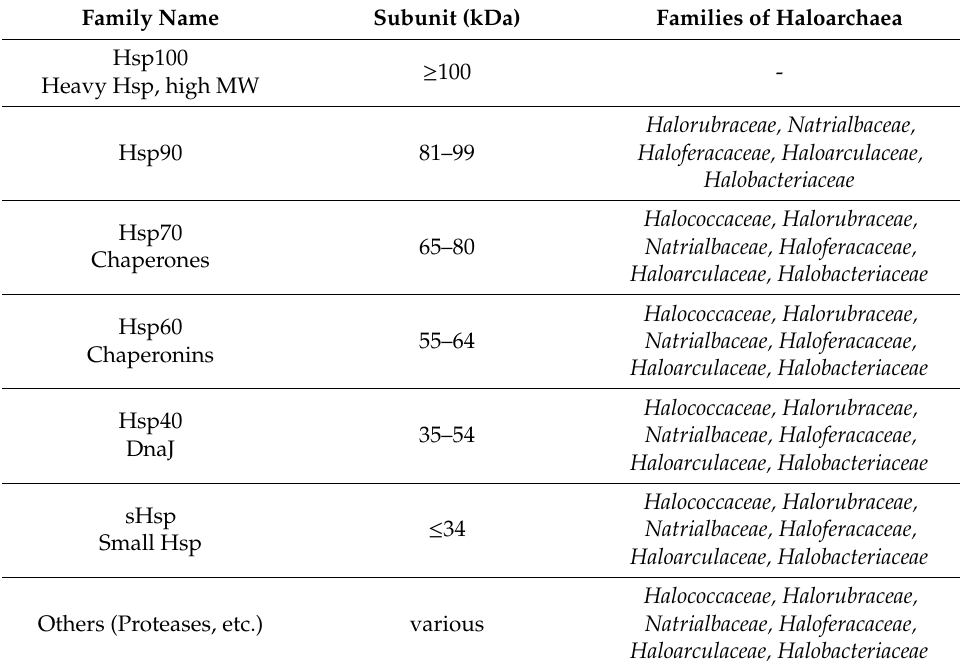
Table 2. Classification of Heat-shock response (Hsp) according to molecular